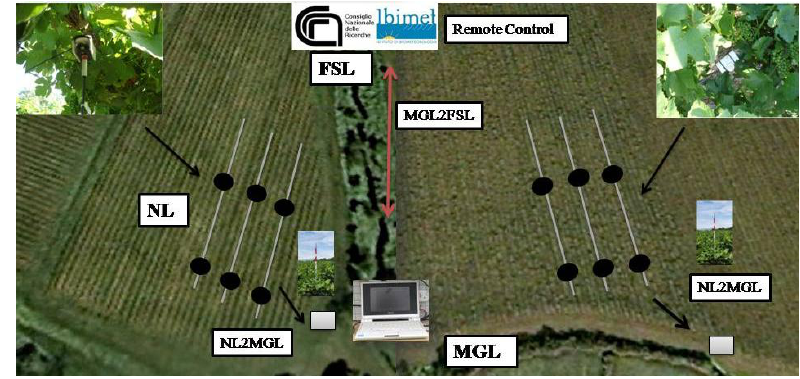
1. Illustration of the on-going implementation of the in-field data